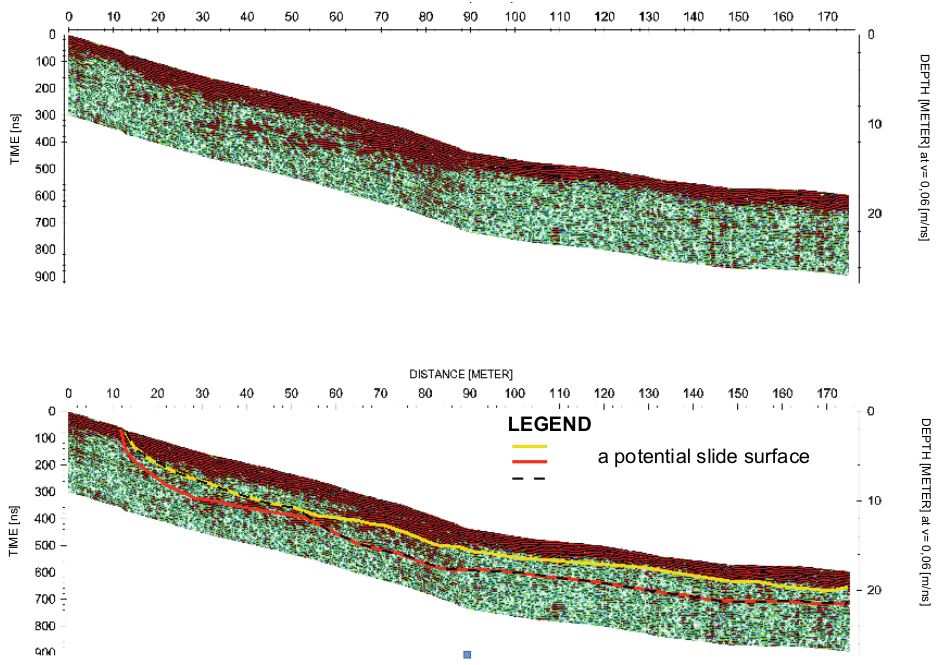
Fig. 3. Echogram P1(a) and echogram P1 with the course of slide surface marked on the graph